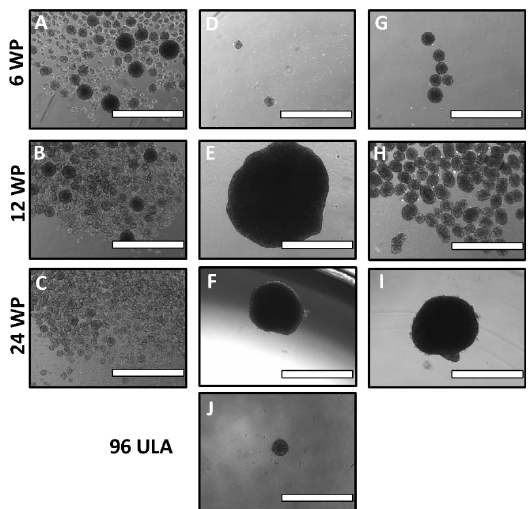
Figure 5. Optimization of well plate size and rotation speed for OVCA420 spheroid production. ( A – C ) OVCA420 spheroids were grown for 72 h in static 6, 12 and 24 WPs, respectively. ( D – F ) Spheroids grown under rotating cell culture at 120 rpm for 72 h in 6, 12 and 24 WPs, respectively. ( G – I ) Spheroids grown under rotating cell culture at 140 rpm for 72 h in 6, 12 and 24 WPs, respectively. ( J ) Static spheroid grown in a round-bottom 96 WP for 72 h. Scale Bar: 1000 µ m.